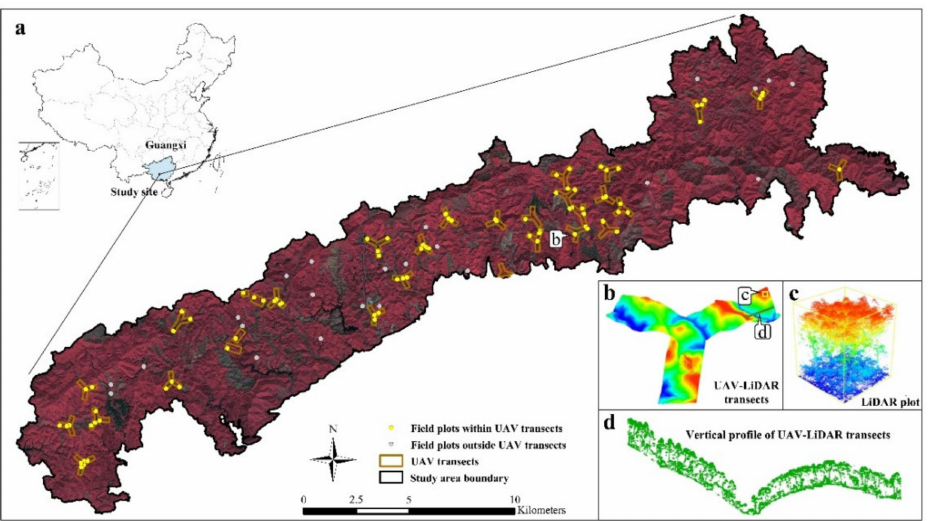
Figure 1. The location of Gaofeng Forest and the distributions of field plots and UAV-LiDAR transects. The satellite imagery was the GF-6 imagery with band composite of 4,3,2 in southern China ( a ). The point clouds of the UAV-LiDAR transects ( b ) were extracted with the vertical profile with 1 m widths ( d ) and the normalized LiDAR plot is shown in sub-figure ( c